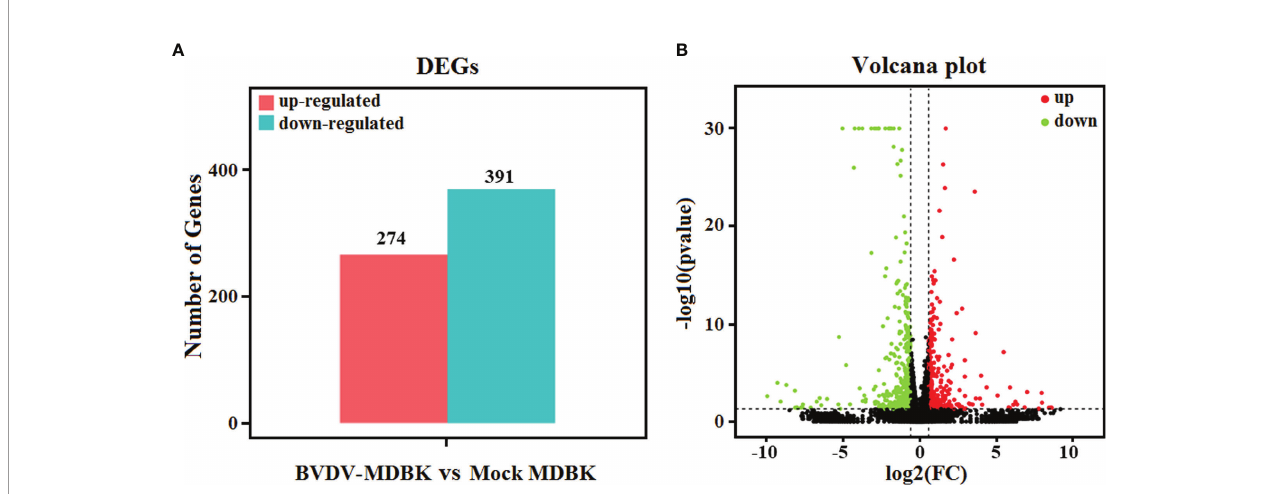
FIGURE 2 | (A) Statistics for the DEGs according to the RNA-seq-based transcriptomics data for BVDV-infected MDBK cells compared to mock-infected MDBK cells. The red histogram represents the number of up-regulated DEGs, and the blue histogram represents the number of down-regulated DEGs. (B) Volcano plot of the DEGs. The red dots represent signi fi cantly up-regulated genes, green dots represent signi fi cantly down-regulated genes, and black dots represent insigni fi cant